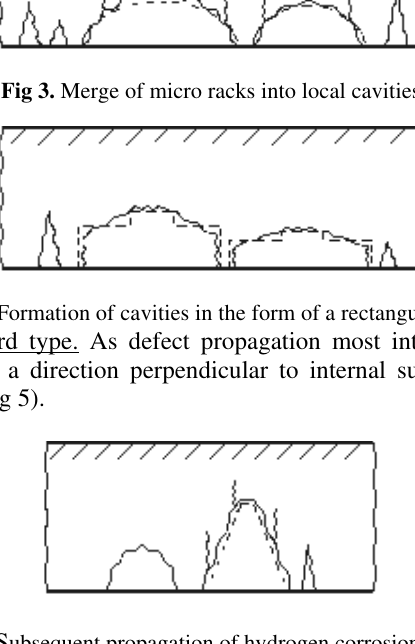
Fig 5. S ubsequent propagation of hydrogen corrosion defect, which is nearing a conic form